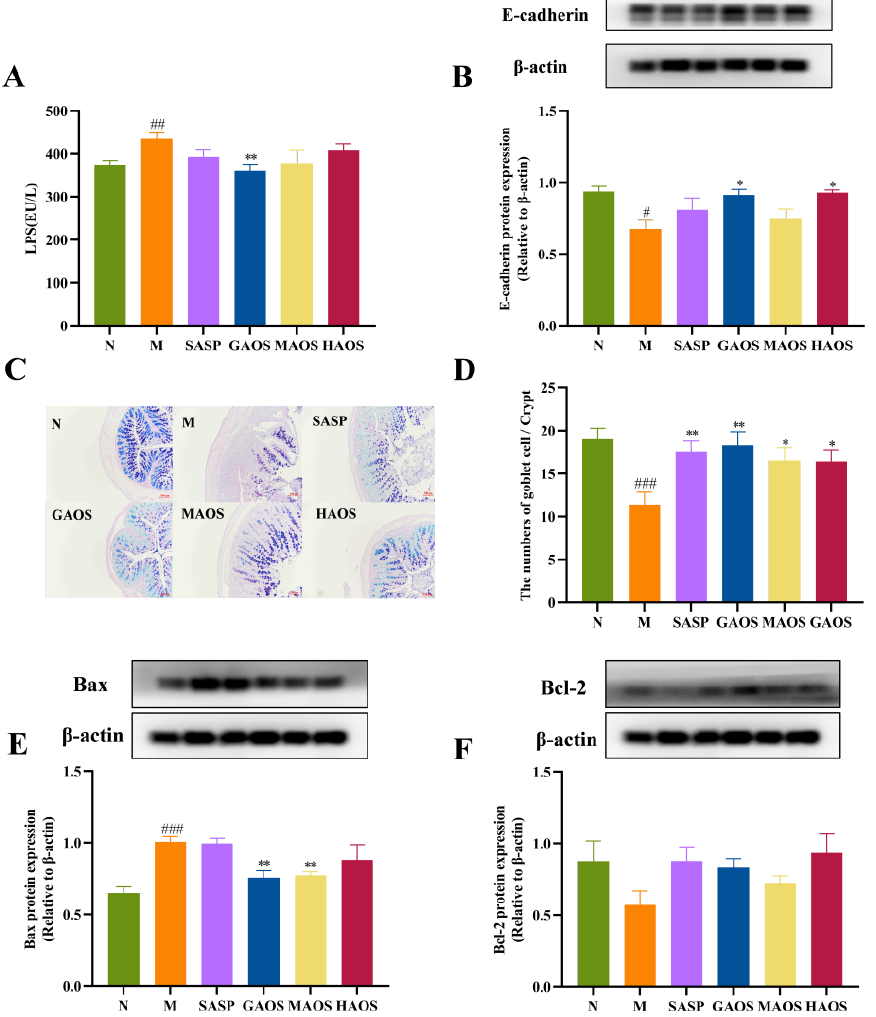
Figure 3. Effects of alginate oligosaccharides on the intestinal mucosal barrier in DSS-induced colitis mice. ( A ) The levels of LPS in serum ( n = 8). ( B ) The protein levels of E-cadherin. The relative intensities of E-cadherin ( n = 3). ( C ) Images of AB-PAS-stained sections of the colon (magnification ×400). ( D ) Goblet cell number per villus ( n = 8). ( E ) The protein levels of Bax ( n = 3). ( F ) The protein levels of Bcl-2 ( n = 3). Data were mean ± SEM. # p < 0.05, ## p < 0.01, ### p < 0.001 vs. the N group; * p < 0.05, ** p < 0.01 vs. the M group.